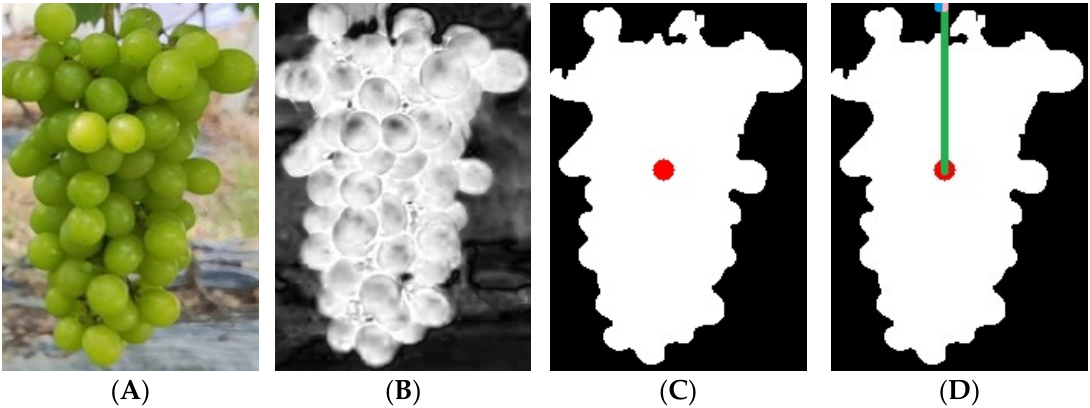
Figure 14. Positioning process diagram. Original image ( A ). H channel image ( B ). Center of mass ( C ) and Lower extreme point ( D ).